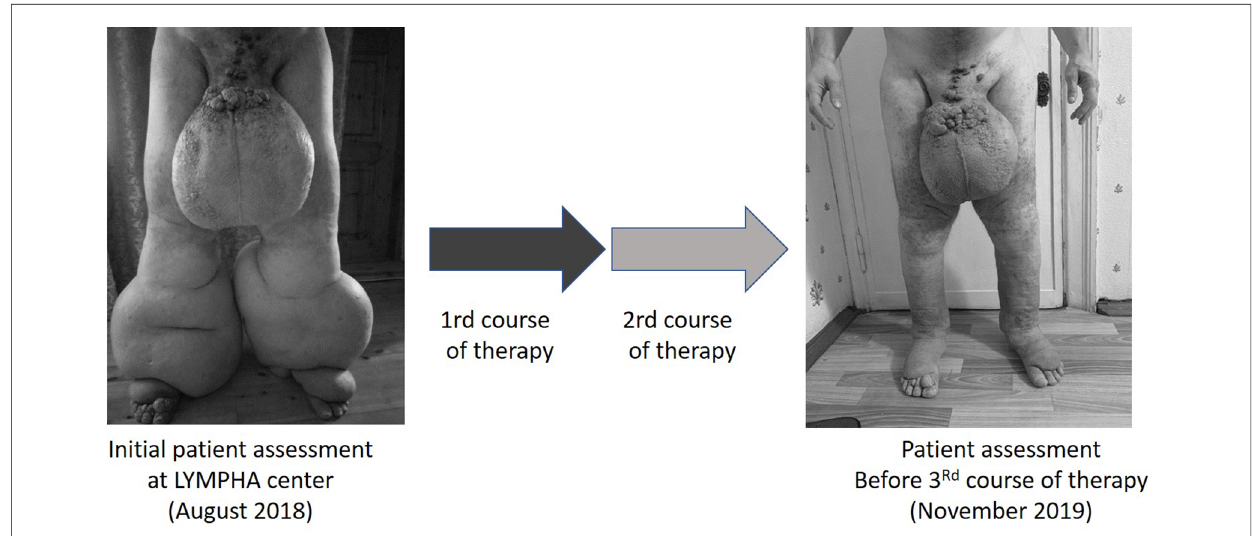
FIGURE 1 Patient ’ s conditions before and at the time of treatments. Microphotography patient assessment at the time of hospital admission ( A , August 2018) and before 3rd course of therapy ( B , November